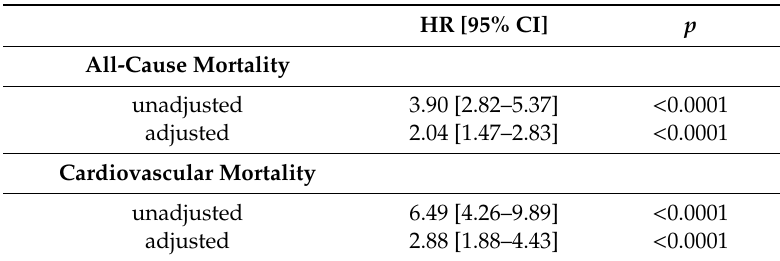
Table 4. Association of incident atrial fibrillation (AF) with